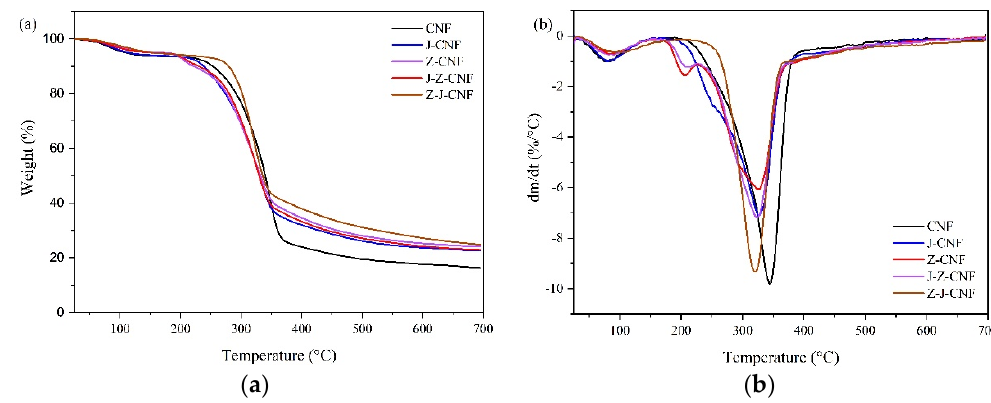
Figure 6. ( a ) thermogravimetric (TG); and ( b ) derivative thermogravimetric (DTG) curves of the CNF and modified